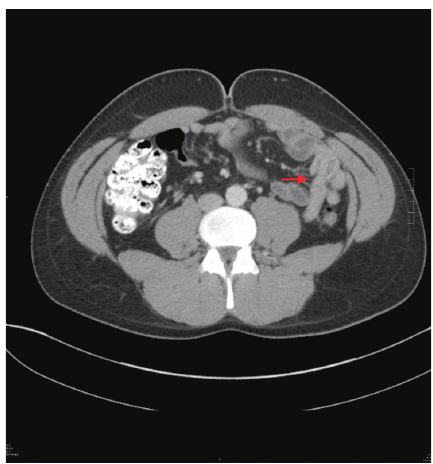
Figure 1: Focal small bowel intussusception in the jejunum.